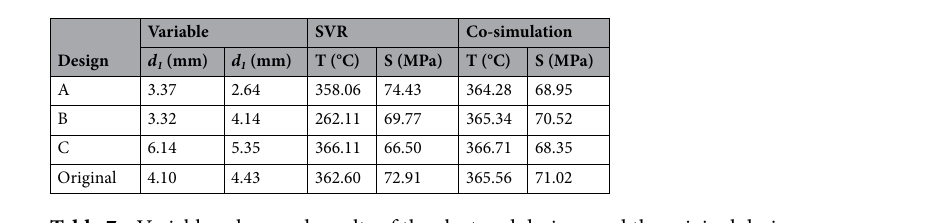
Table 7. Variable values and results of the clustered designs and the original